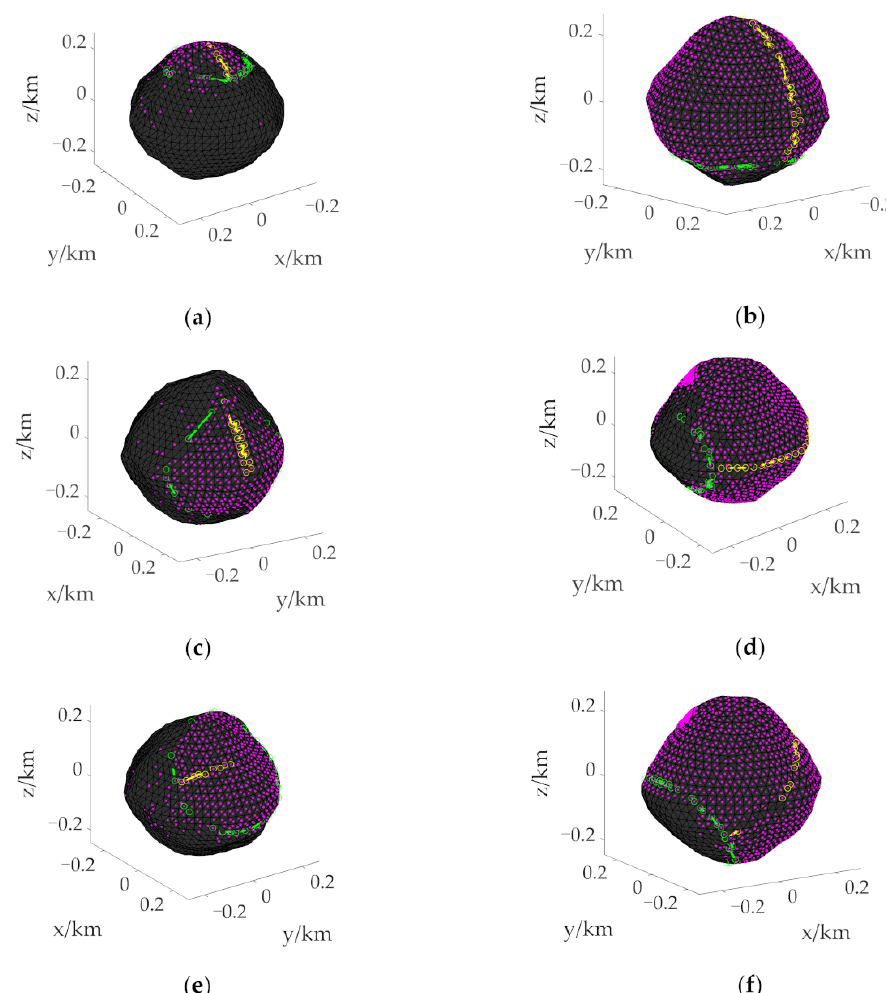
Figure 5. Initial boundary of the reachable domain under different initial states. ( a ) Initial boundary for landing from over the North Pole with t f = 700 s. ( b ) Initial boundary for landing from over the North Pole with t f = 900 s. ( c ) Initial boundary for landing from over the Equator with t f = 700 s. ( d ) Initial boundary for landing from over the Equator with t f = 900 s. ( e ) Initial boundary for landing from over the mid-latitude region with when t f = 700 s. ( f ) Initial boundary for landing from over the mid-latitude region with when t f = 900 s. The yellow “o” stand for points with feasible solutions between parallel planes. The green “o” stand for points that make up the initial boundary. The purple dots indicate the points with feasible solutions on the asteroid